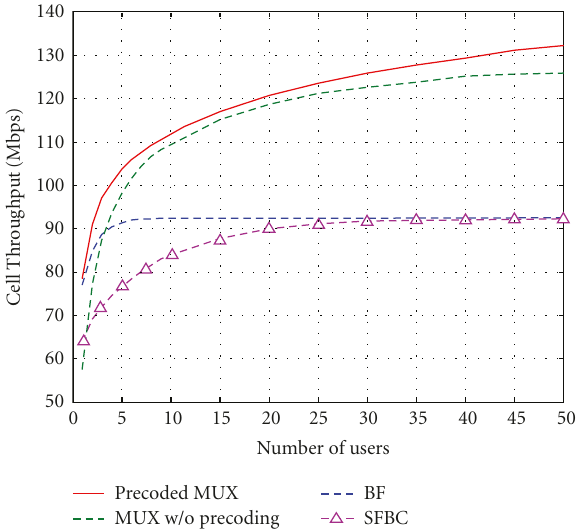
Figure 14: Multiuser diversity gain with Proportional Fair schedul- ing (average SNR 20dB).